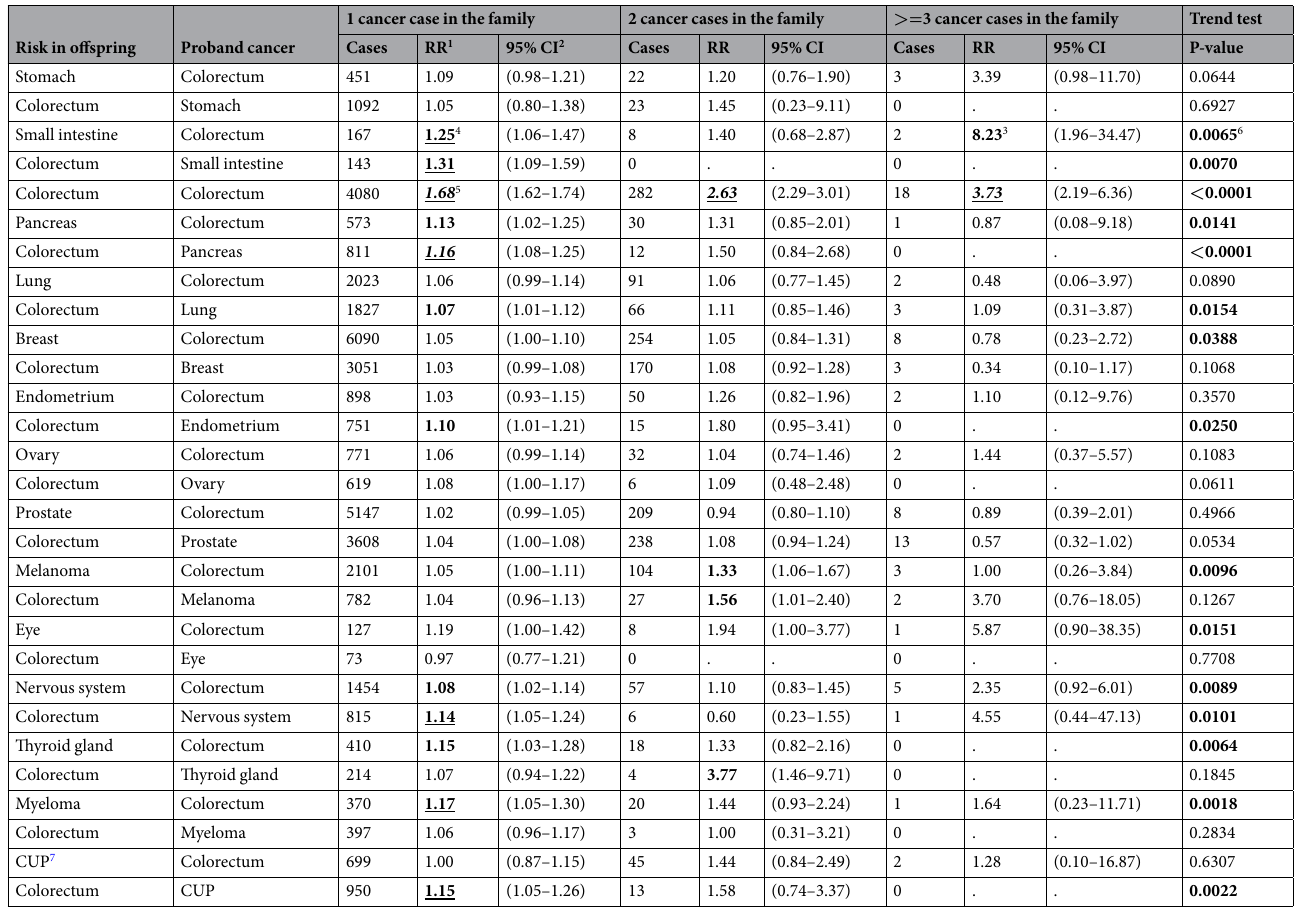
Table 2. Discordant and concordant risks for CRC in non-HNPCC families. 1 RR = relative risk. 2 CI = confidence interval. 3 Bold type denotes significantly increased RR at the two-sided 5% level. 4 Bold and underlined value denotes significantly increased RR at the two-sided 1% level. 5 Bold, underlined and Italics wvalue denotes significantly increased RR at the two-sided 0.1% level. 6 Bold type denotes that trend test was statistically significant. 7 CUP = cancer of unknown